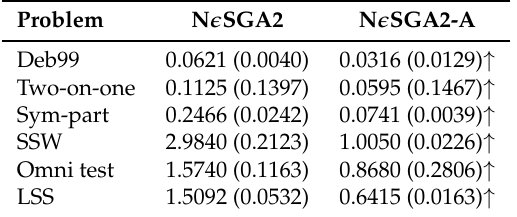
Table 2. Averaged ∆ 2 in decision space for the use of the external archiver and the base case.